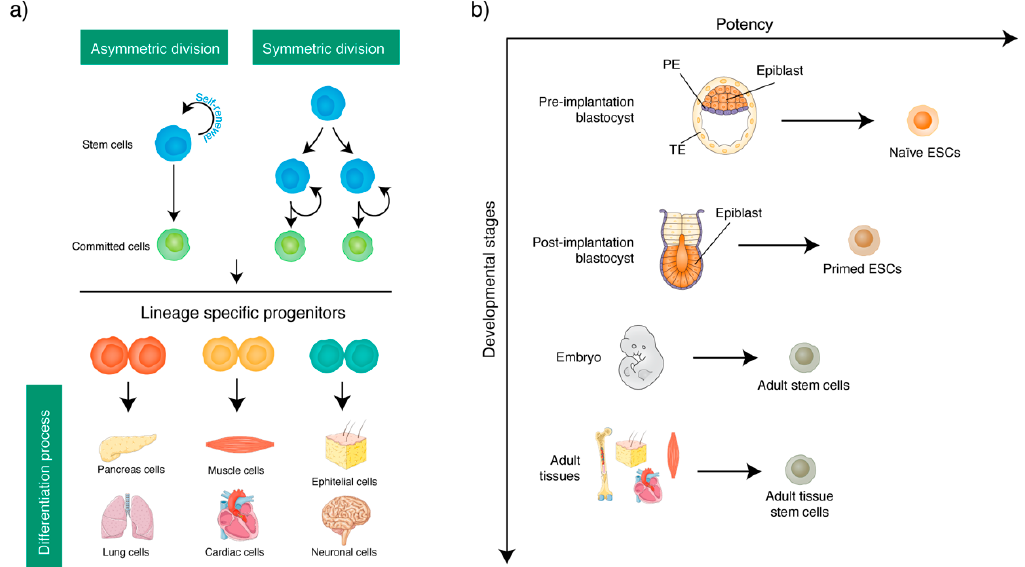
Figure 1. Paradigm of stem cells. ( a ) Asymmetric and symmetric division of stem cells give rise committed cells that generate lineage specific progenitors. The latter generate differentiated cells. ( b ) The cartoon shows the origin of the different stem cell types during the developmental stages.